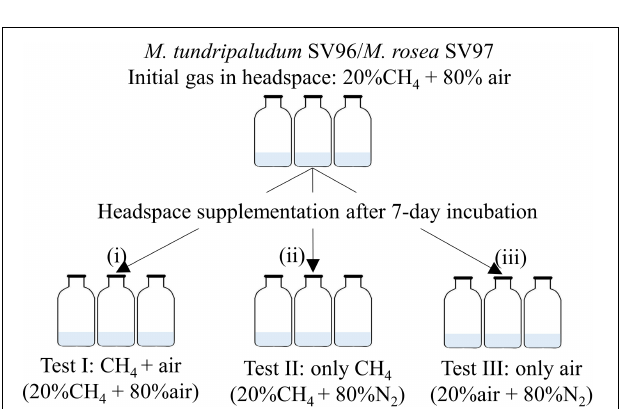
FIGURE 2 | Experimental setup for methanotrophs under three different gas supplementation schemes applied on day 7 including test I: both CH 4 and air added, test II only CH 4 added, and test III only air